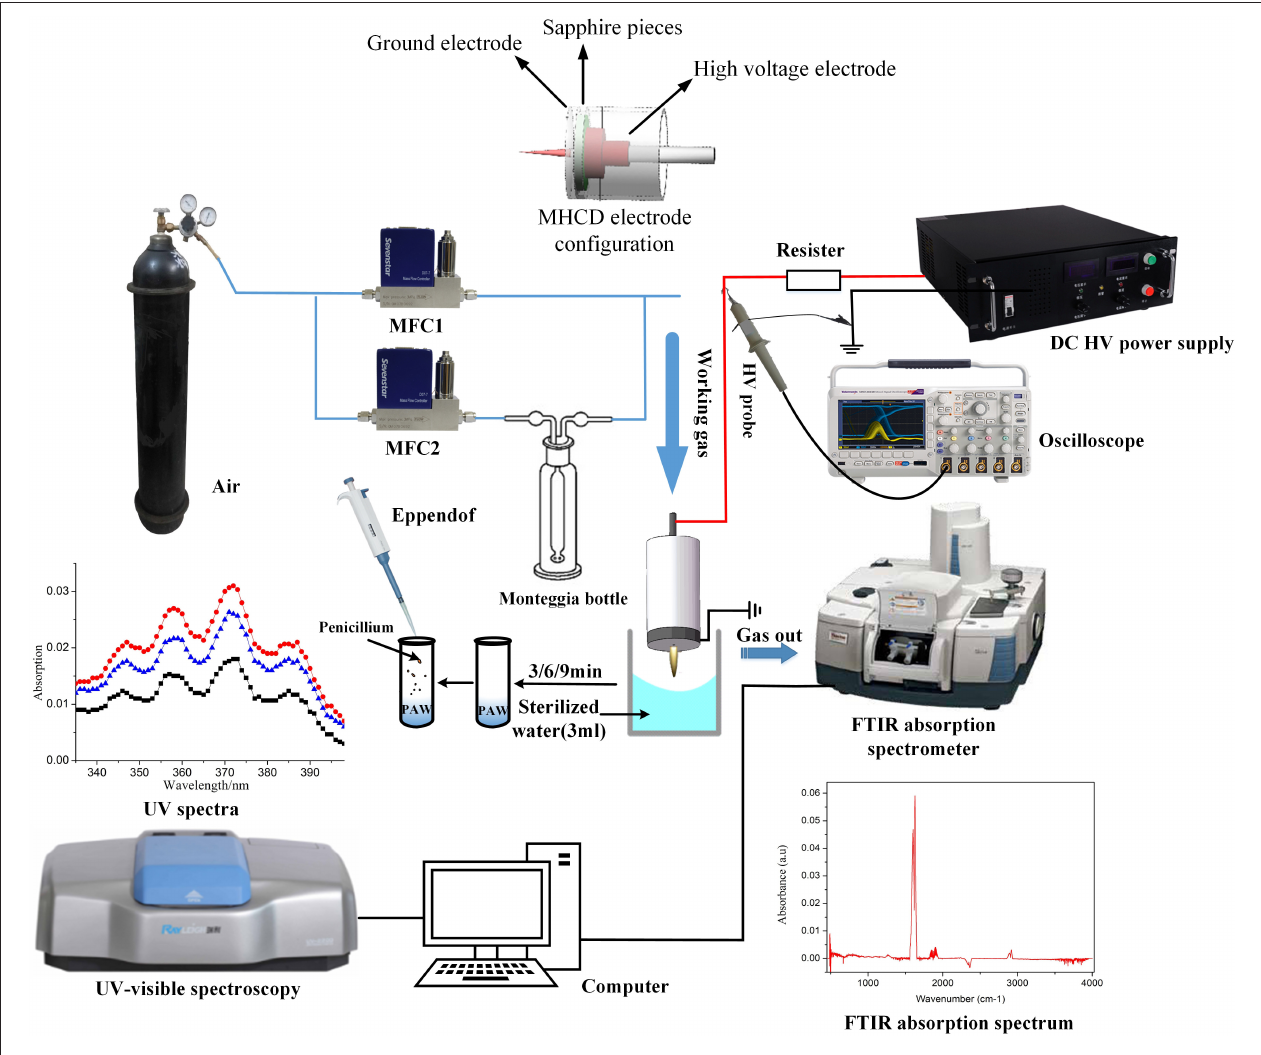
FIGURE 1 | Schematic diagram of the experimental